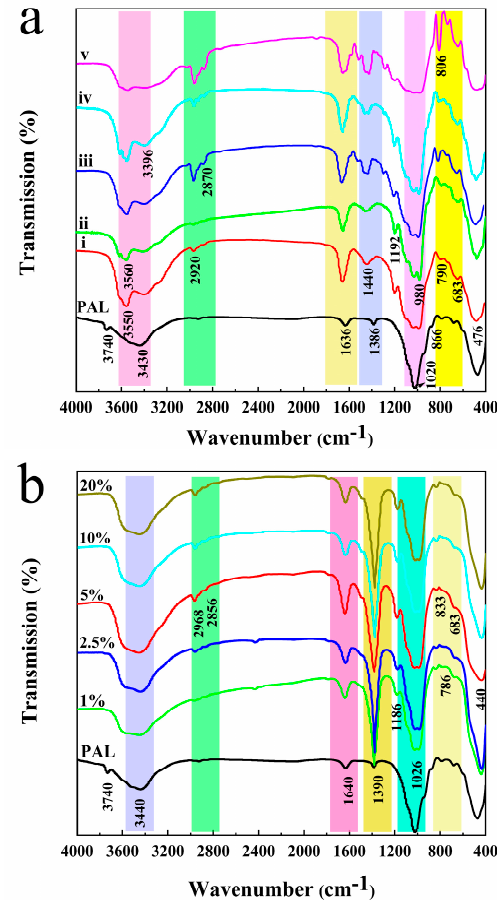
Figure 2. FTIR spectra of PEOs/ZnO/PAL (i) citral, (ii) thymol, (iii) CAR, (iv) oregano oil, (v) cinnamaldehyde, ( a ) and CAR/ZnO/PAL with different concentrations of CAR ( b ).